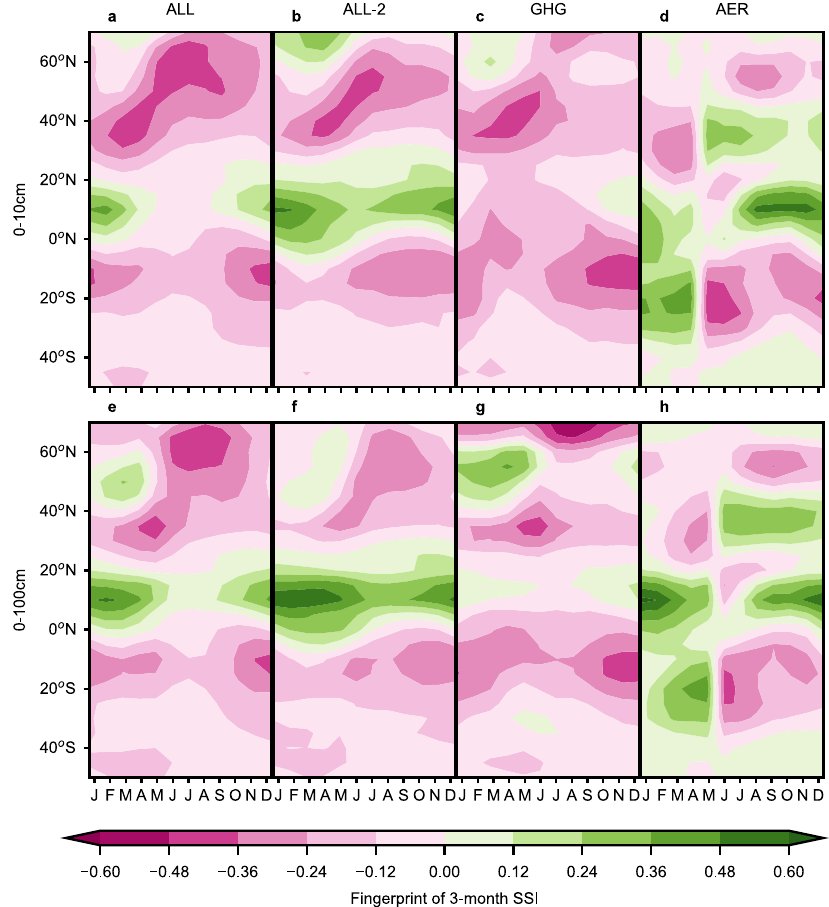
Fig. 2 | Month-by-latitude fi ngerprints of the CMIP6 simulations under differ- ent forcings for the 3-month Standardized Soil Moisture Index (SSI) in the 0 – 10cm and 0 – 100cm soil layers. a – h The forcings abbreviations are: ALL and ALL-2 — forced by all anthropogenic and natural forcing agents, GHG — forced by anthropogenic greenhouse gases only, AER — forced by anthropogenic aerosols